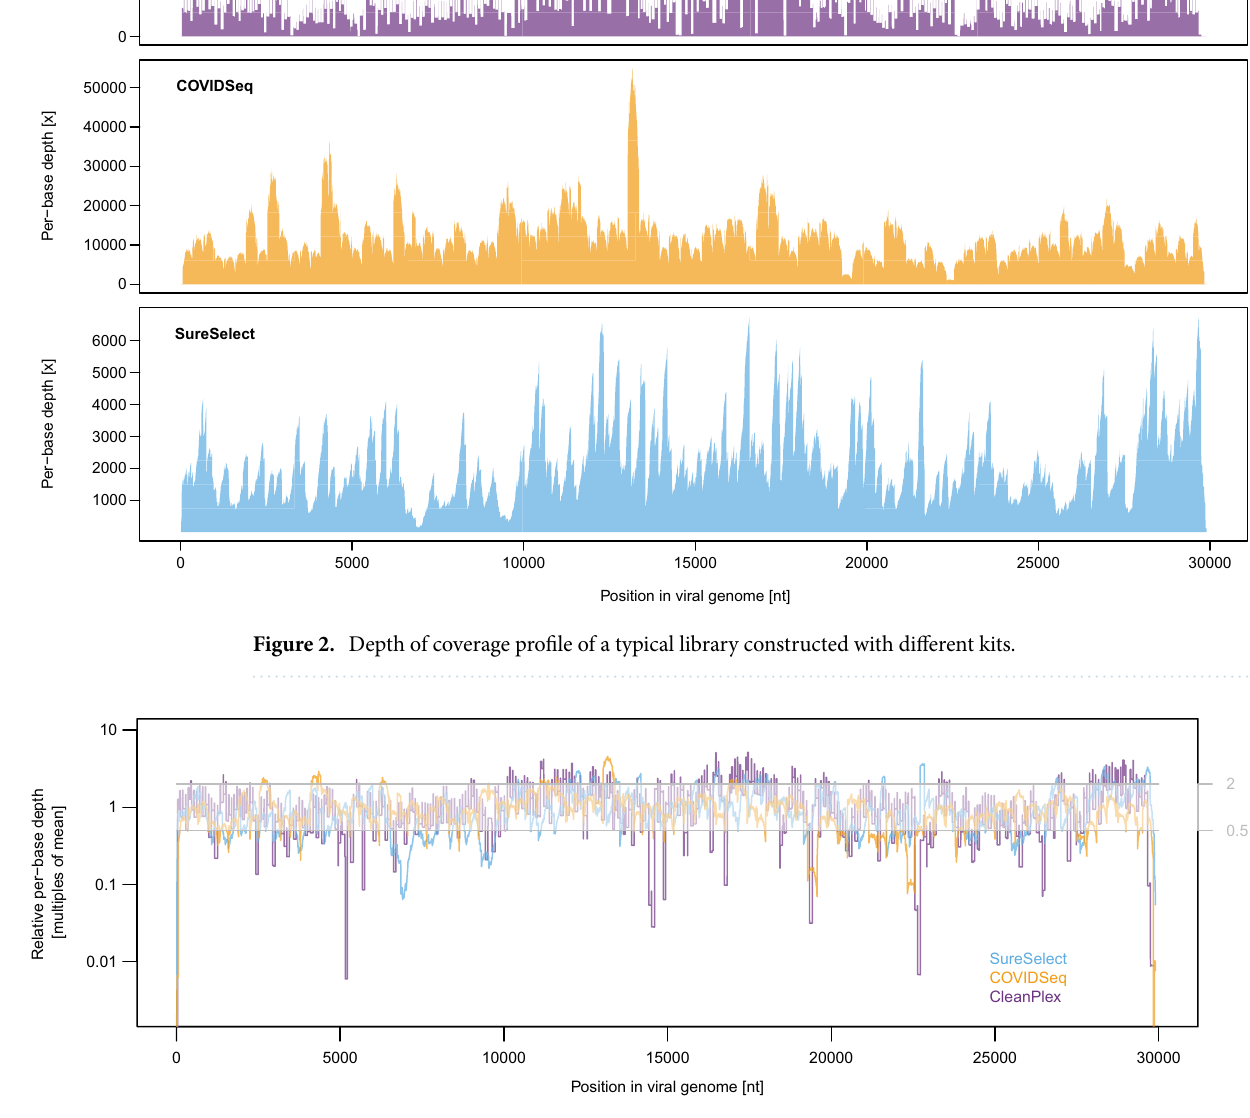
Figure 3. Departure from optimal depth of coverage. Relative depth was determined by comparing per-base depth to the mean depth of each library. Horizontal grey lines mark the optimal range between half the mean and twice the mean value (displayed on the right side of the